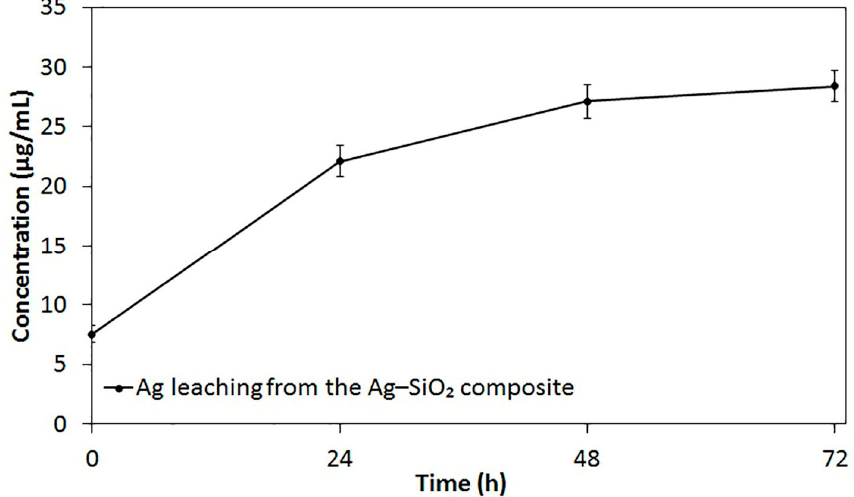
Figure 3. In vitro leaching profile of Ag from the filtered aqueous suspensions of the Ag–SiO 2 composite (1 mg/mL), shaken at regular time intervals, shown as the average values of triplicate measurements. The bars represent the standard errors of the